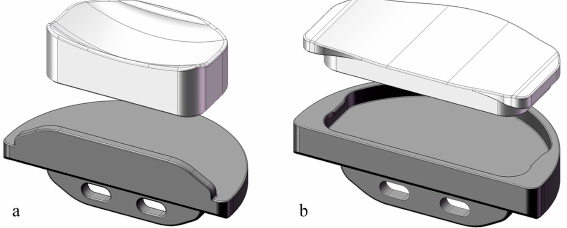
Fig.1. Two constructional options of partial knee replacement